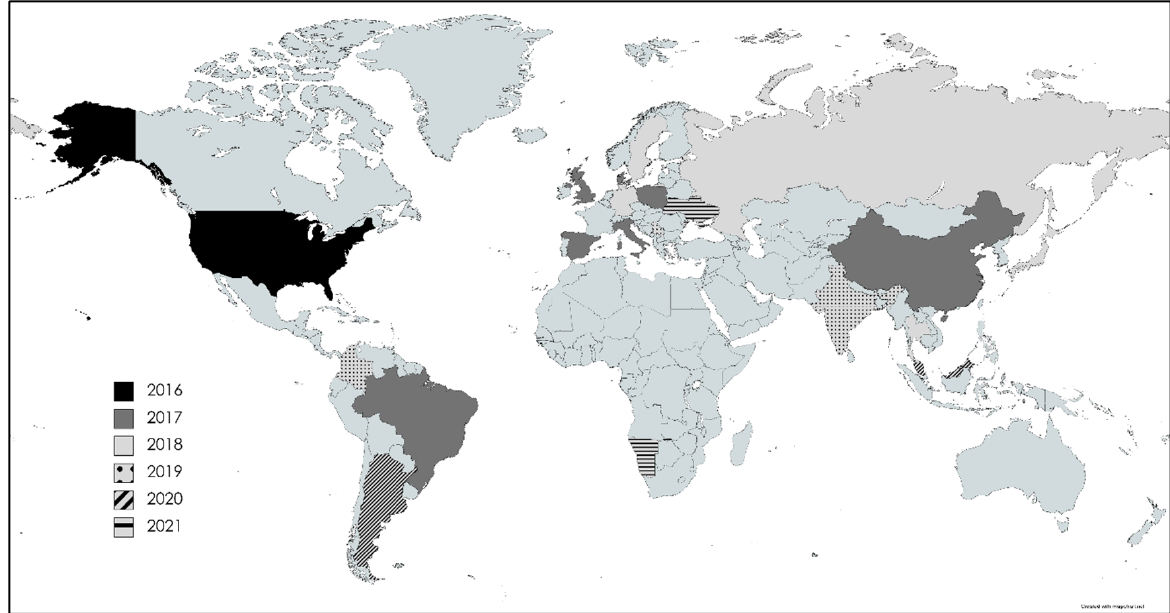
Figure 1. The worldwide occurrence of PCV3.